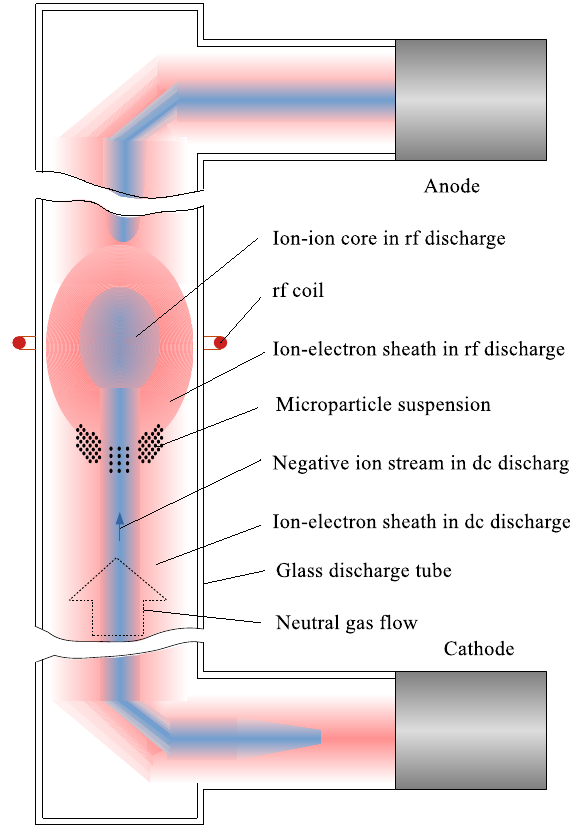
Figure 1. Sketch of the experimental set up used in